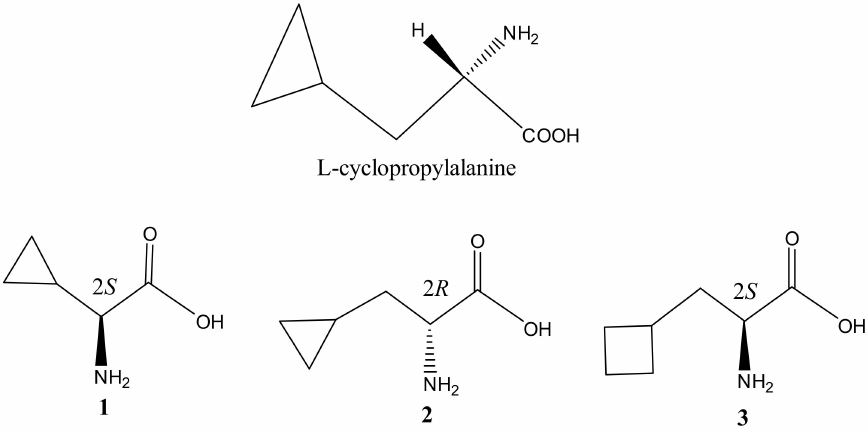
Figure 2. L -Cyclopropylalanine and its derivatives compounds 1 , 2 and 3